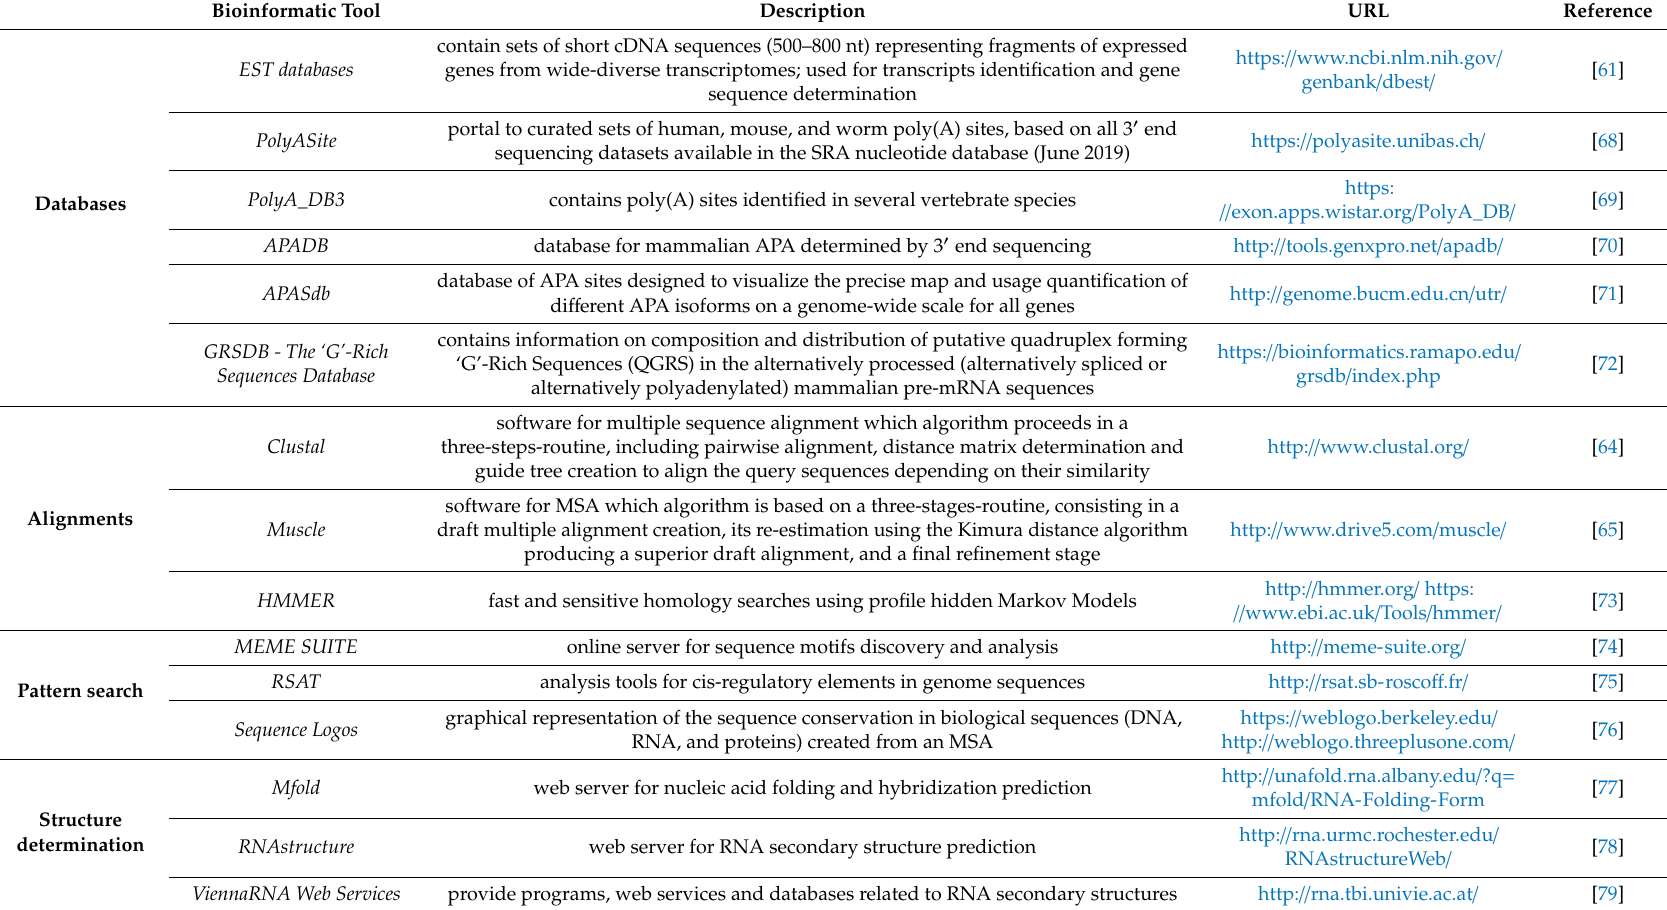
Table 1. Bioinformatics tools for PASes detection and